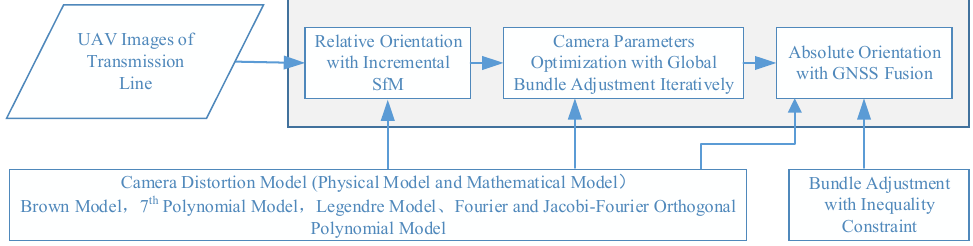
Figure 2. The camera self-calibration workflow for long corridor UAV images.